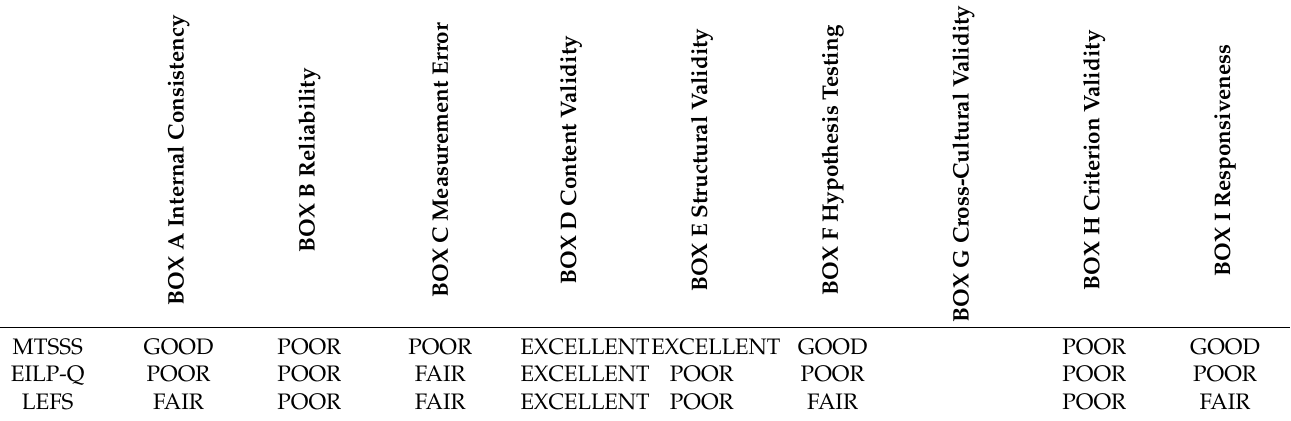
Table 4. COSMIN methodological quality scores for measurement properties of PROMs * [46].